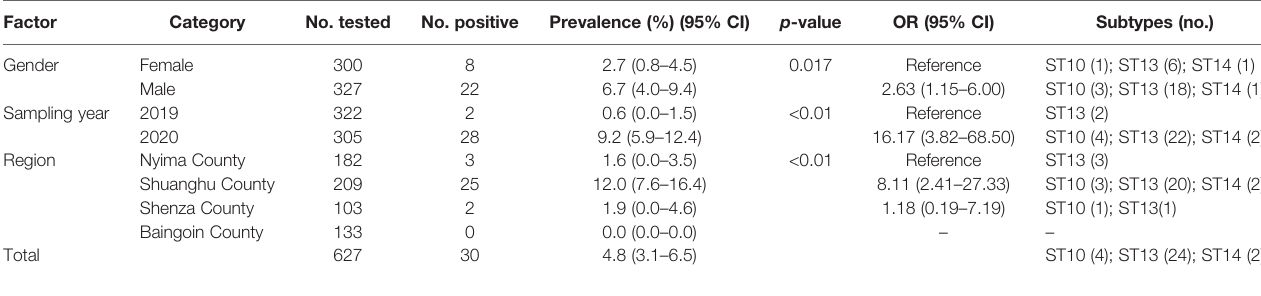
TABLE 3 | Occurrence and subtype distribution of Blastocystis sp. in tibetan antelope ( Pantholops hodgsonii ). Factor